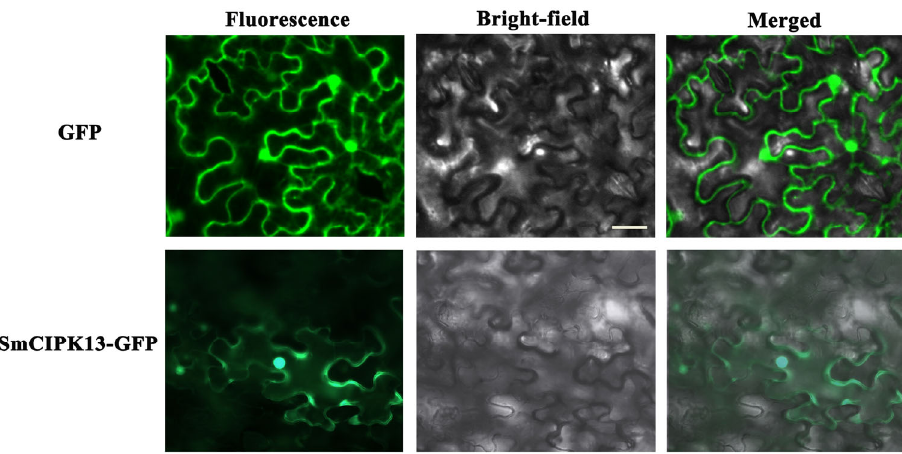
Figure 6. Subcellular localization of SmCIPK13 in tobacco. The scale represents 100 μ m. and Arabidopsis,